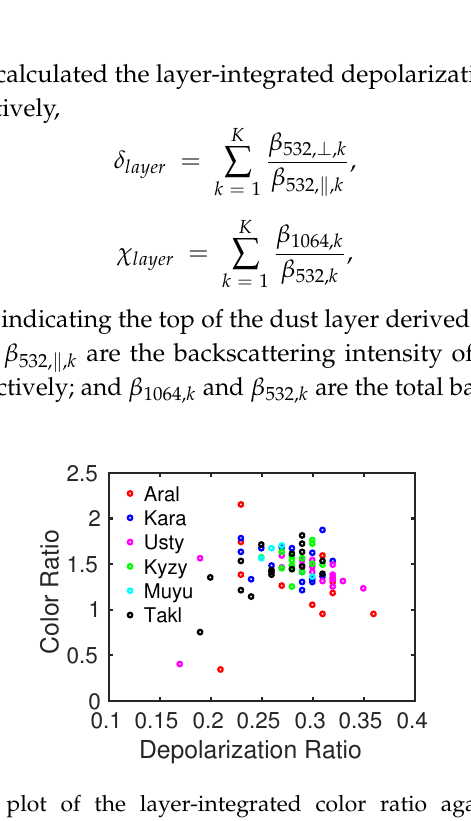
Figure 14. The scatter plot of the layer-integrated color ratio against the layer-integrated depolarization